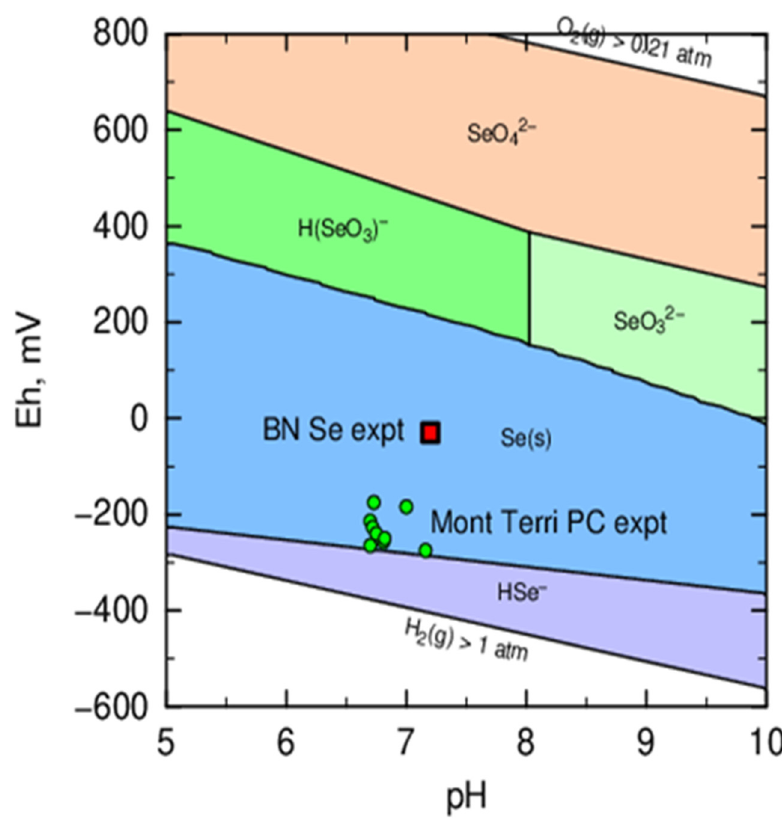
Figure 13. Pourbaix diagram showing the stability of Se aqueous species and more reduced Se species compared to the in situ steady state Eh and pH conditions of the BN Se injection test (red square) and measurements from the Mont Terri Pore water Chemistry (PC) experiment (green circles) [55]. Calculated for a total Se concentration of 50 µM using PHREEPLOT [49] with the Thermochimie database [47].